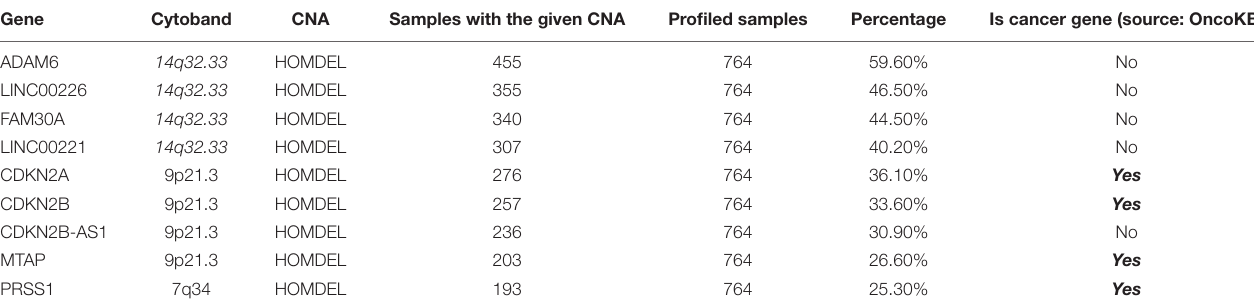
TABLE 2 | Distribution of genes with the highest percentage of chromosomal changes in the profiled samples. Gene Cytoband CNA Samples with the given CNA Profiled samples Percentage Is cancer gene (source: OncoKB)